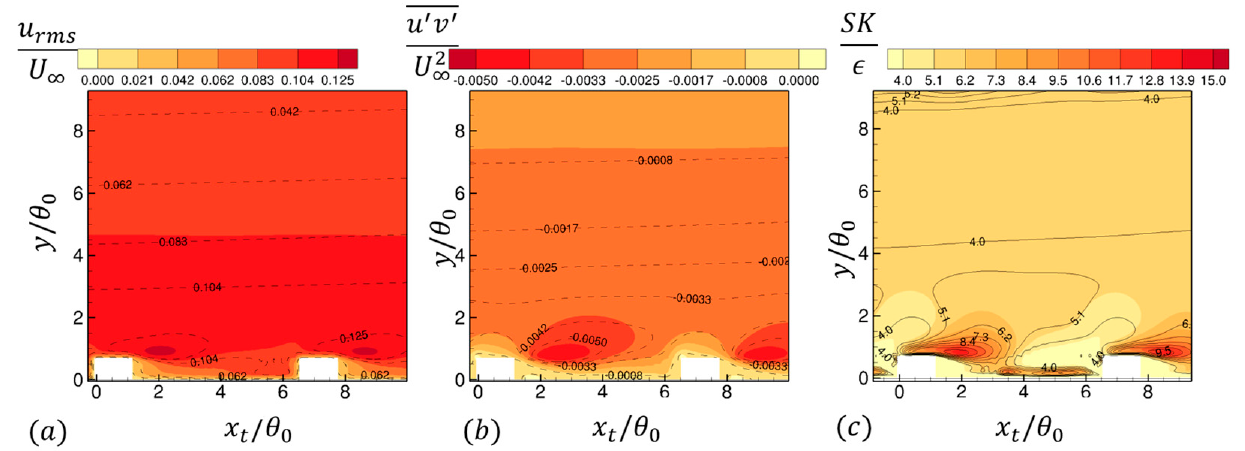
Figure 14. Streamwise distribution of ( a ) u rms / U ∞ , ( b ) u (cid:48) v (cid:48) / U 2 ∞ , and ( c ) SK / (cid:101) inside and above a roughness canopy at z = 0.5 k c . The coordinate for the x -axis is defined as x t = x − x n , where x n = 101.2 (lines) and x n = 398.2 (color).